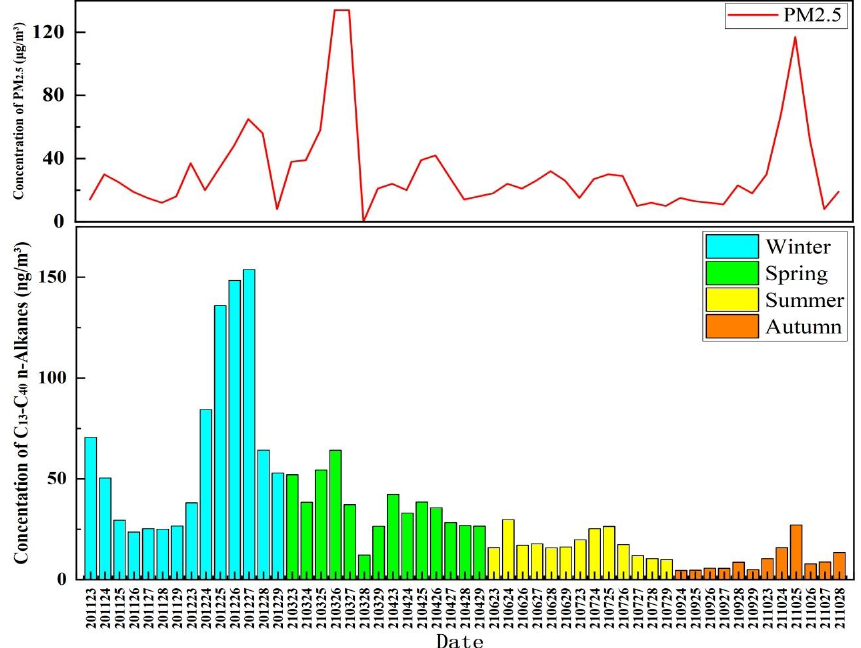
Figure 1. Temporal variations in PM 2 . 5 and particulate-bound n -alkane concentrations during the sampling period in Beijing. (The concen- trations of C 13 –C 40 n -alkanes and PM 2 . 5 are the average of the day and